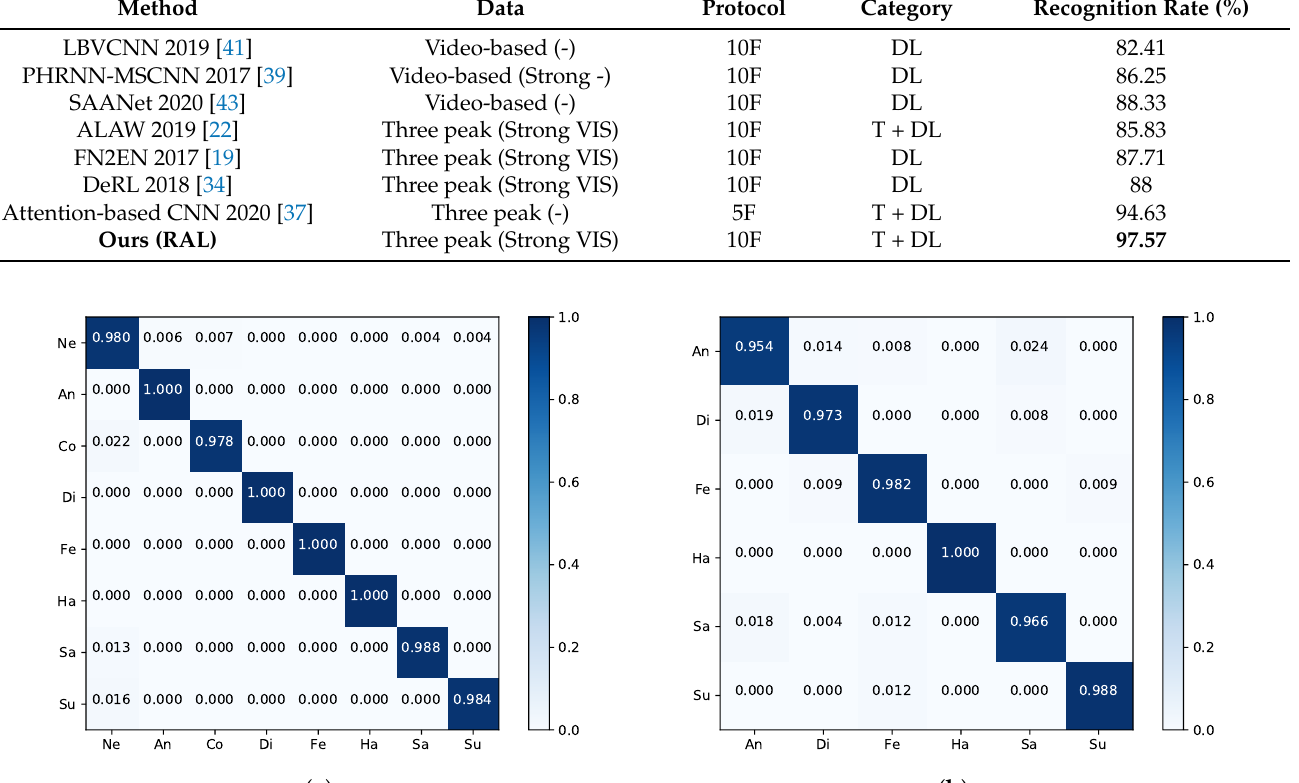
Table 3. Performance comparison with different methods on the Oulu-CASIA. Symbol “-” denotes not reported.